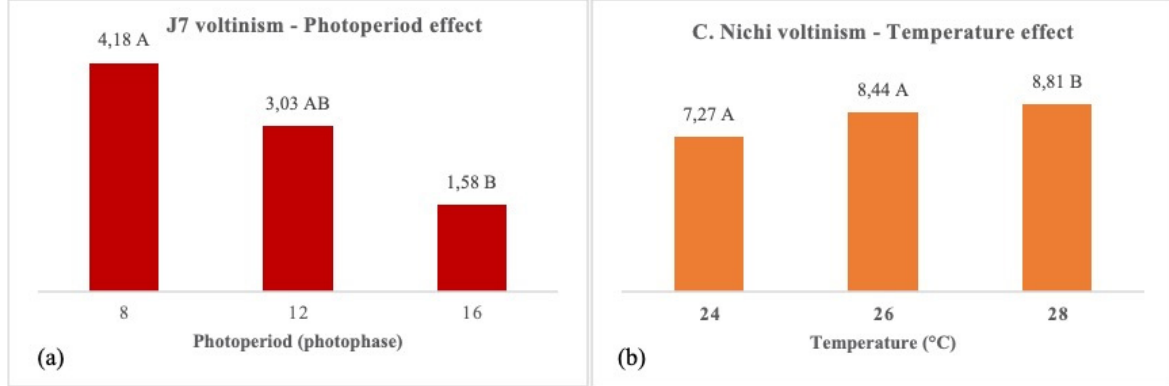
Figure 1. Voltinism means for lines with significant effect of (a) photoperiod (J7) and (b) temperature (C. Nichi). Means with different letter differ statistically at